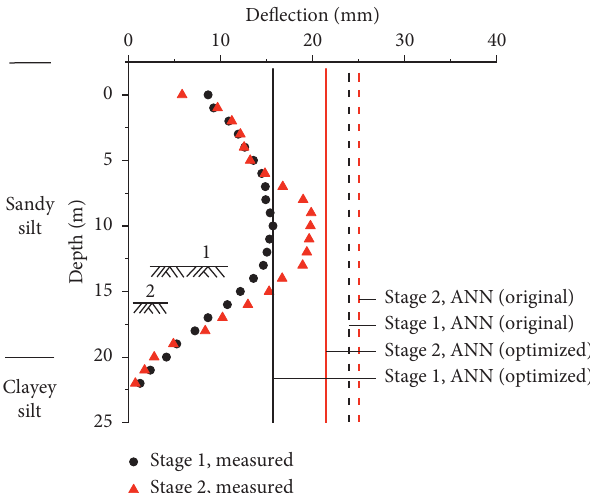
Figure 6: Comparison between measuredretaining wall deflections in thecase study ofHangzhou, China, and thosepredicted by theANN model. Ground surface symbol shows the excavation depths corresponding to the two stages (i.e., stage 1: excavate to 13m; stage 2: excavate to